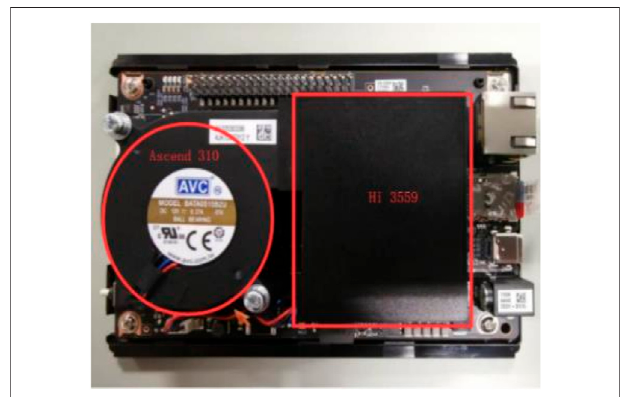
FIGURE 10 | The diagram of edge intelligent analysis module.